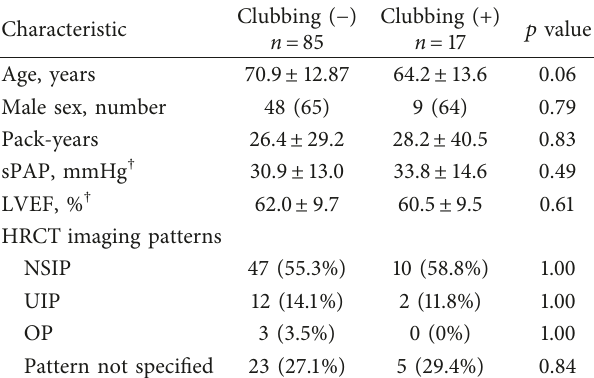
Table 1: Characteristics of